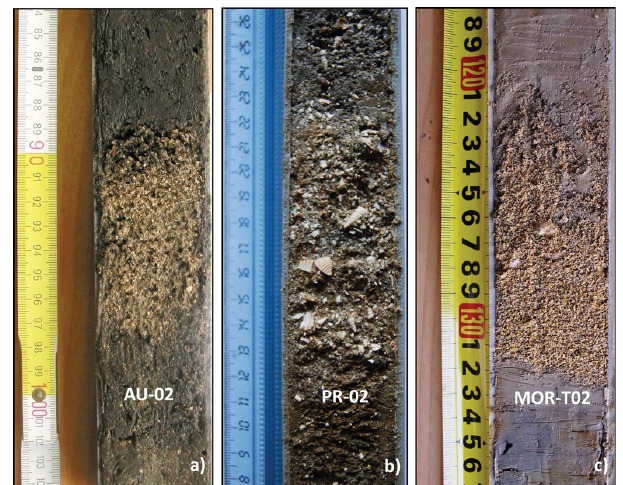
Fig. 3. From left to right, pictures of three distinct tsunami de- posits found at the Augusta, Priolo and Morghella sites, respec- tively. These three layers share some stratigraphical and sedimento- logical characteristics indicative of a tsunami origin sensu Morton et al. (2007). In fact, they appear as relatively thin ( < 25cm), single, massive and structureless beds with abrupt, often erosional, lower